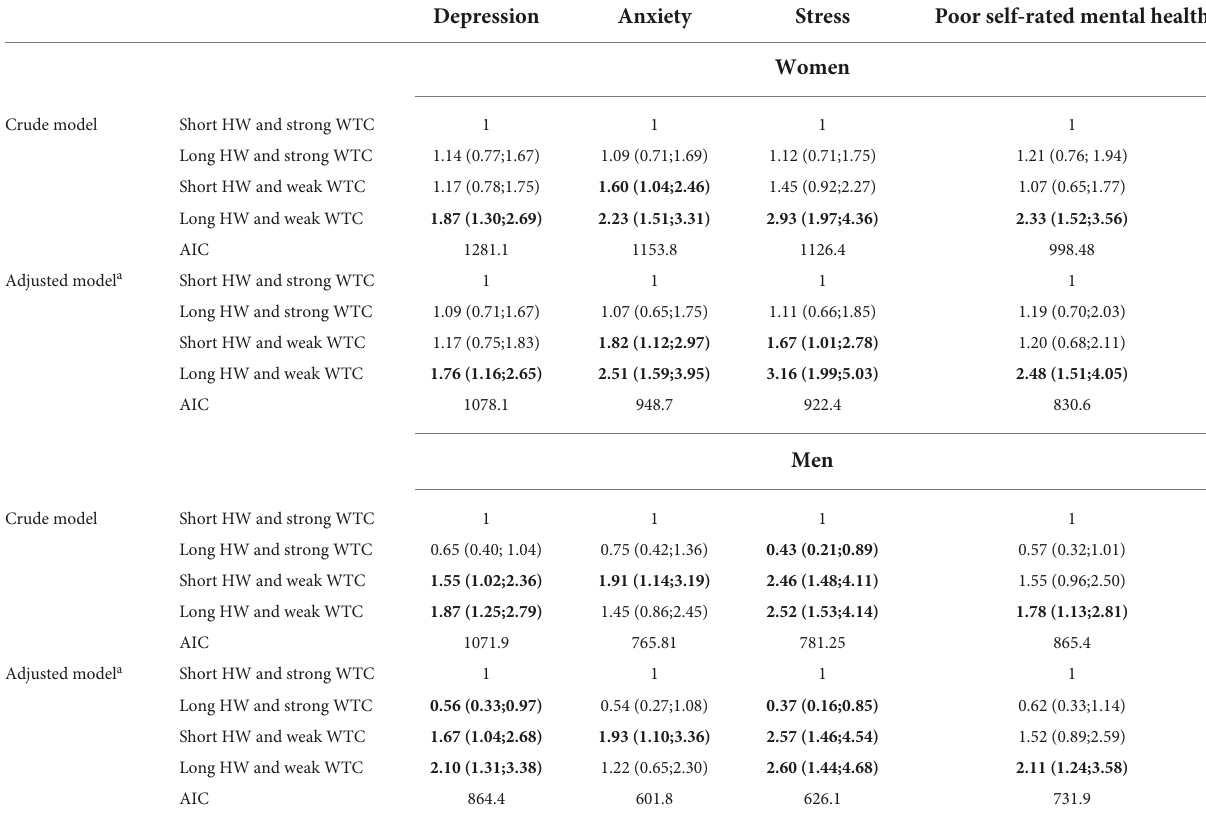
TABLE 4 Crude and adjusted associations (OR 95% CI) between hours worked from home (HW) and work time control (WTC) combined and mental health